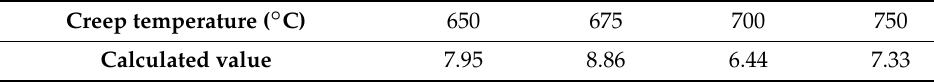
Table 2. Calculated values of the damage tolerance